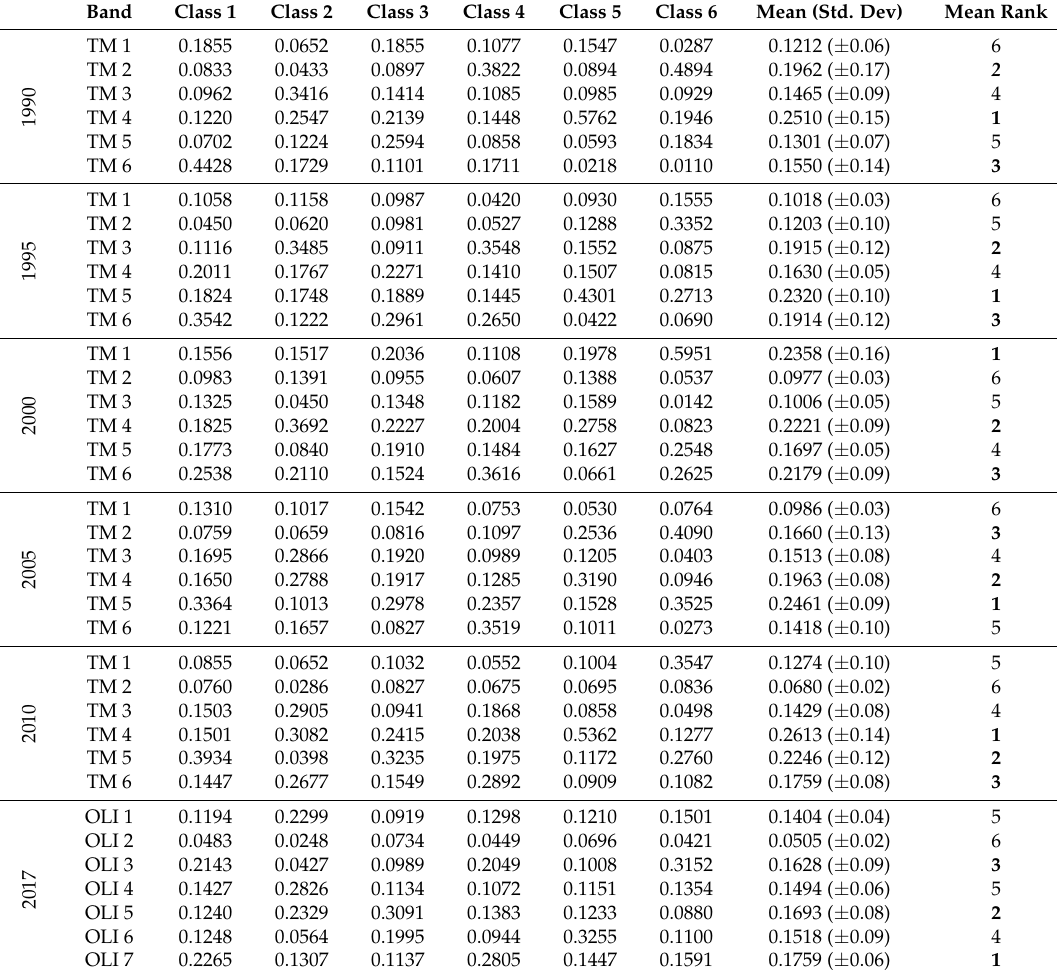
Table 3. Training gain scores for features (reflective bands) used in XGBoost models. The bands corresponding to the bold-faced mean rank values were used in LULC classification using